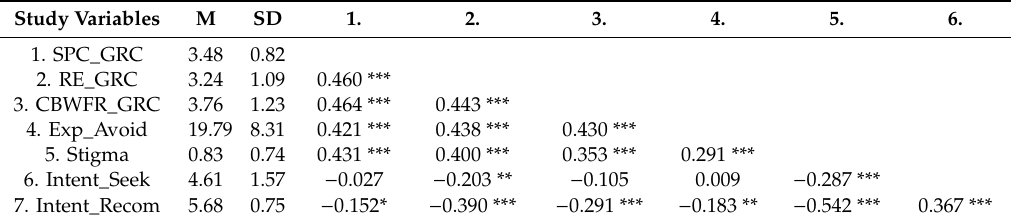
Table 3. Descriptives and Pearson bivariate correlations between the study variables.